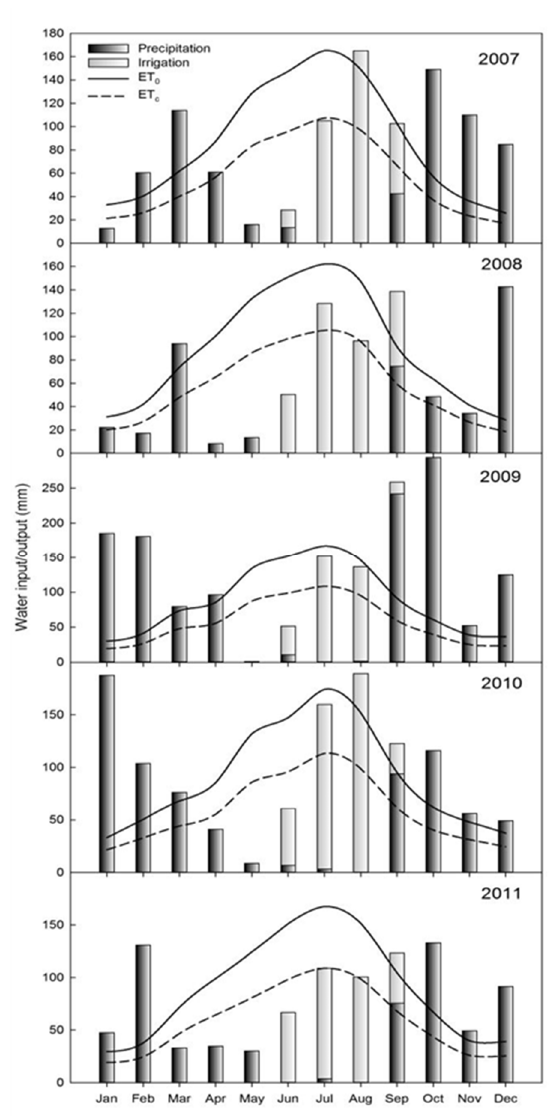
Figure 1. Distribution of total monthly rainfall, irrigation reference (ET 0 ) and crop (ET c ) evapotranspiration during the five years of observations at the experimental site in Palermo (30°06’ N, 13°21’ E, and 31 m a.s.l.), Sicily.